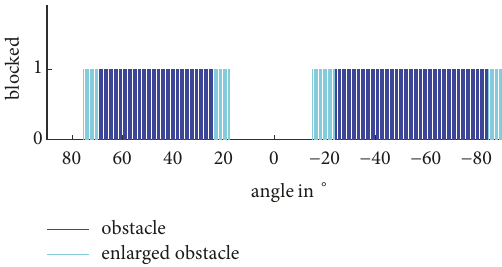
Figure 4: Finding the maximum gap from sensor